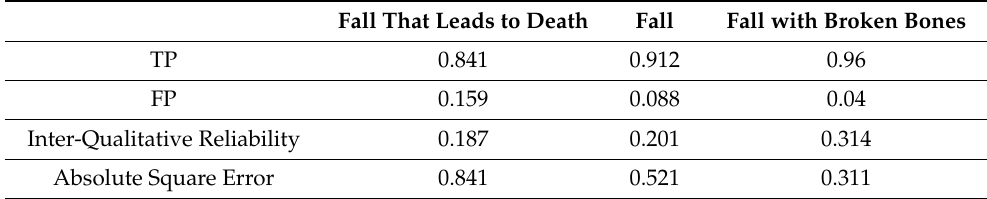
Table 10. Comparison of the prediction time in seconds.